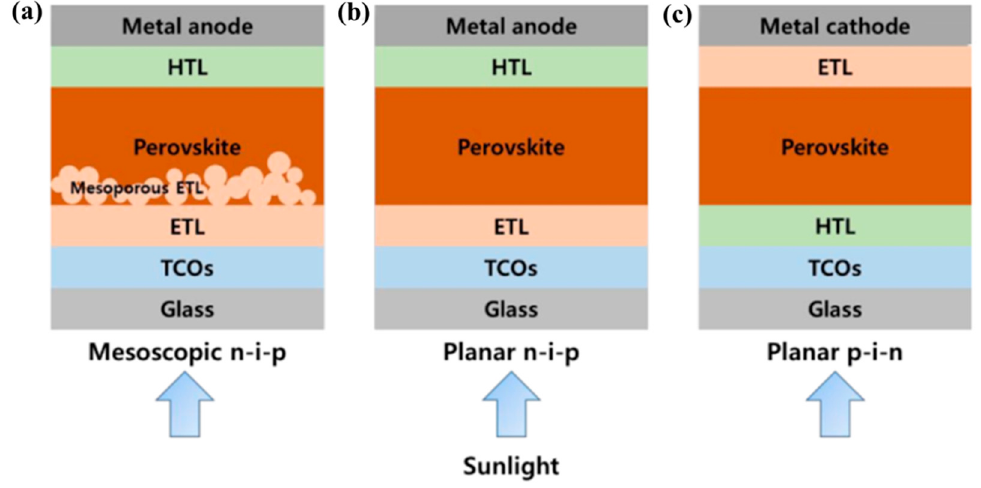
Figure 2. The standard architectures of perovskite solar cells (PSCs): ( a ) mesoporous n-i-p, ( b ) planar n-i-p, and ( c ) planar p-i-n [49].